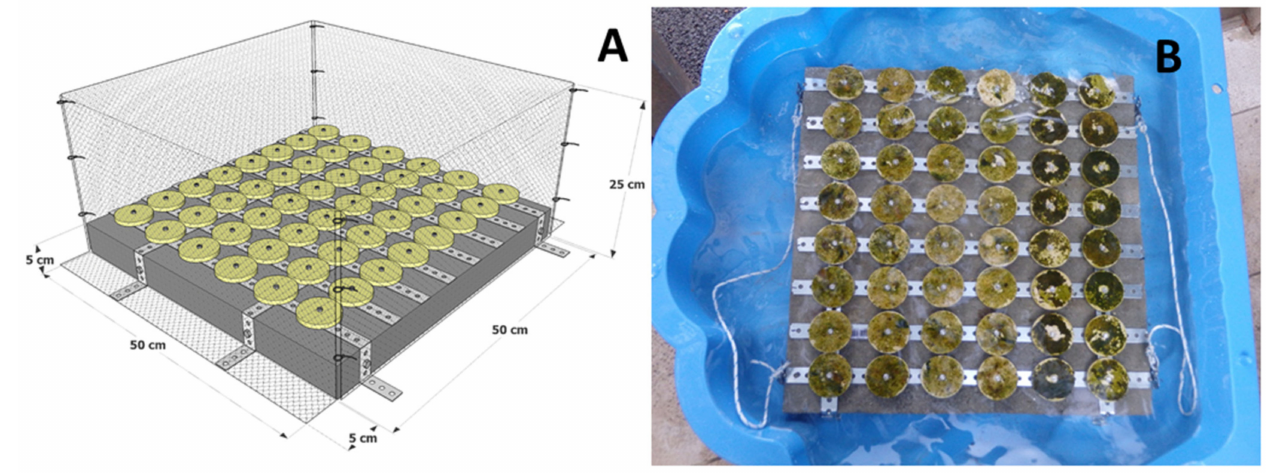
Figure 4. ( A ) Outplanting structure formed by a concrete plate and a protection cage for Gongolaria barbata recruits on clay tiles. ( B ) Two concrete plates with 48 clay tiles each, completely covered also by biofilm, were placed in the sea on day